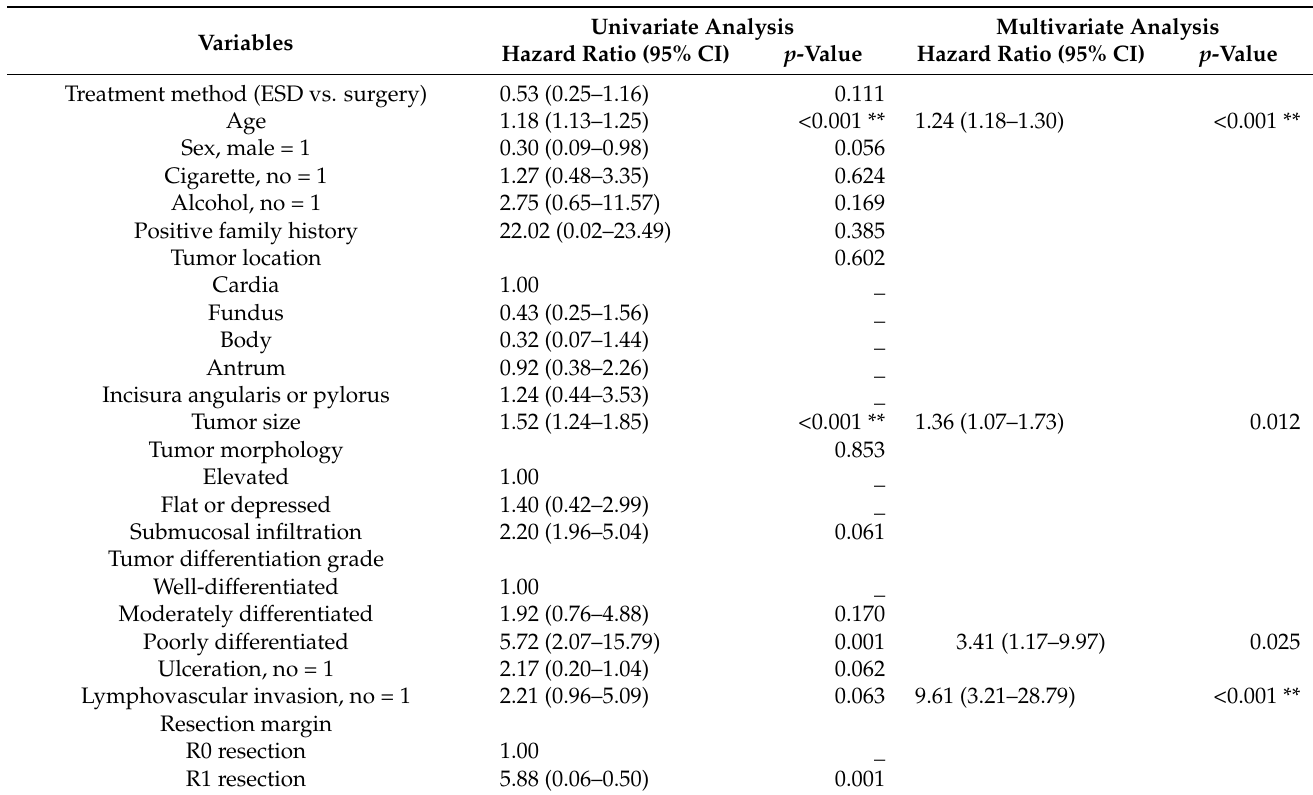
Table 6. Univariate and multivariate regression analyses of recurrence-free survival for propensity score-matching